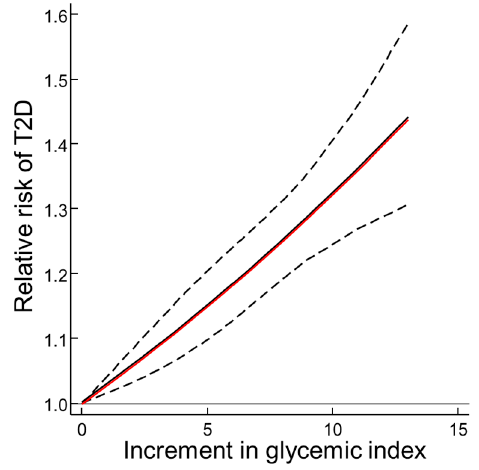
Figure 1. Local dose-dependence of the relative risk of T2D on Glycemic Index in prospective cohort studies combined. Analysis was on the log relative risk (RR) and is shown exponentiated to RR. All studies had a validity correlation coefficient for their dietary instrument > 0.55 for carbohydrate and reported by 3 or more quantiles. The slope (black continuous line) and 95% confidence intervals (dashed lines) derived from restricted (natural) cubic spline meta-regression ( glst ) with three knots at 0, 5 and 11 unit increment in GI. For comparison a log-linear dose response is also shown (red). There was no significant evidence for departure from log linearity ( P > 0.989 for the secondary spline determinant). Thus the plots (red compared with black) overlapped consistently throughout the range. The log-linear dose-response T2D-GI risk relation rose by 32% per 10 unit increment in GI, i.e., RR = 1.32 (1.25–1.40), P < 0.001, n = 8 studies including 29 increments in GI. The mean GI at the intercept was 55 units GI based on the glucose (GI = 100) scale. The studies were Bhupathiraju et al. (2 studies, HPFS and NHS II) [19], Oba et al. in men [55], Mekary et al. (NHS I) [30], Sakurai et al. [41], Villegas et al. [34], Sahyoun et al. [45] and van Woudenbergh et al. [42]. Abbreviations: GI, glycemic index; RR, relative risk; T2D, type 2 diabetes.